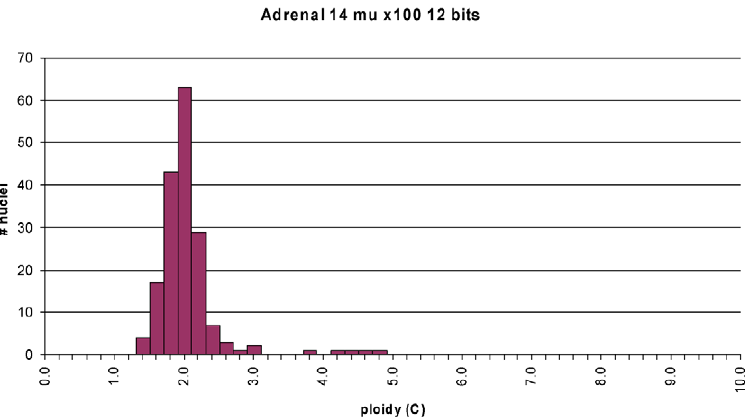
Fig. 2. Example of DNA histogram obtained by 3D DNA confocal laser scanning based image cytometry of 14 µ m thick section of adrenal tissue, stained with TO-PRO-3 after 1 hour RNase application and imaging at ×